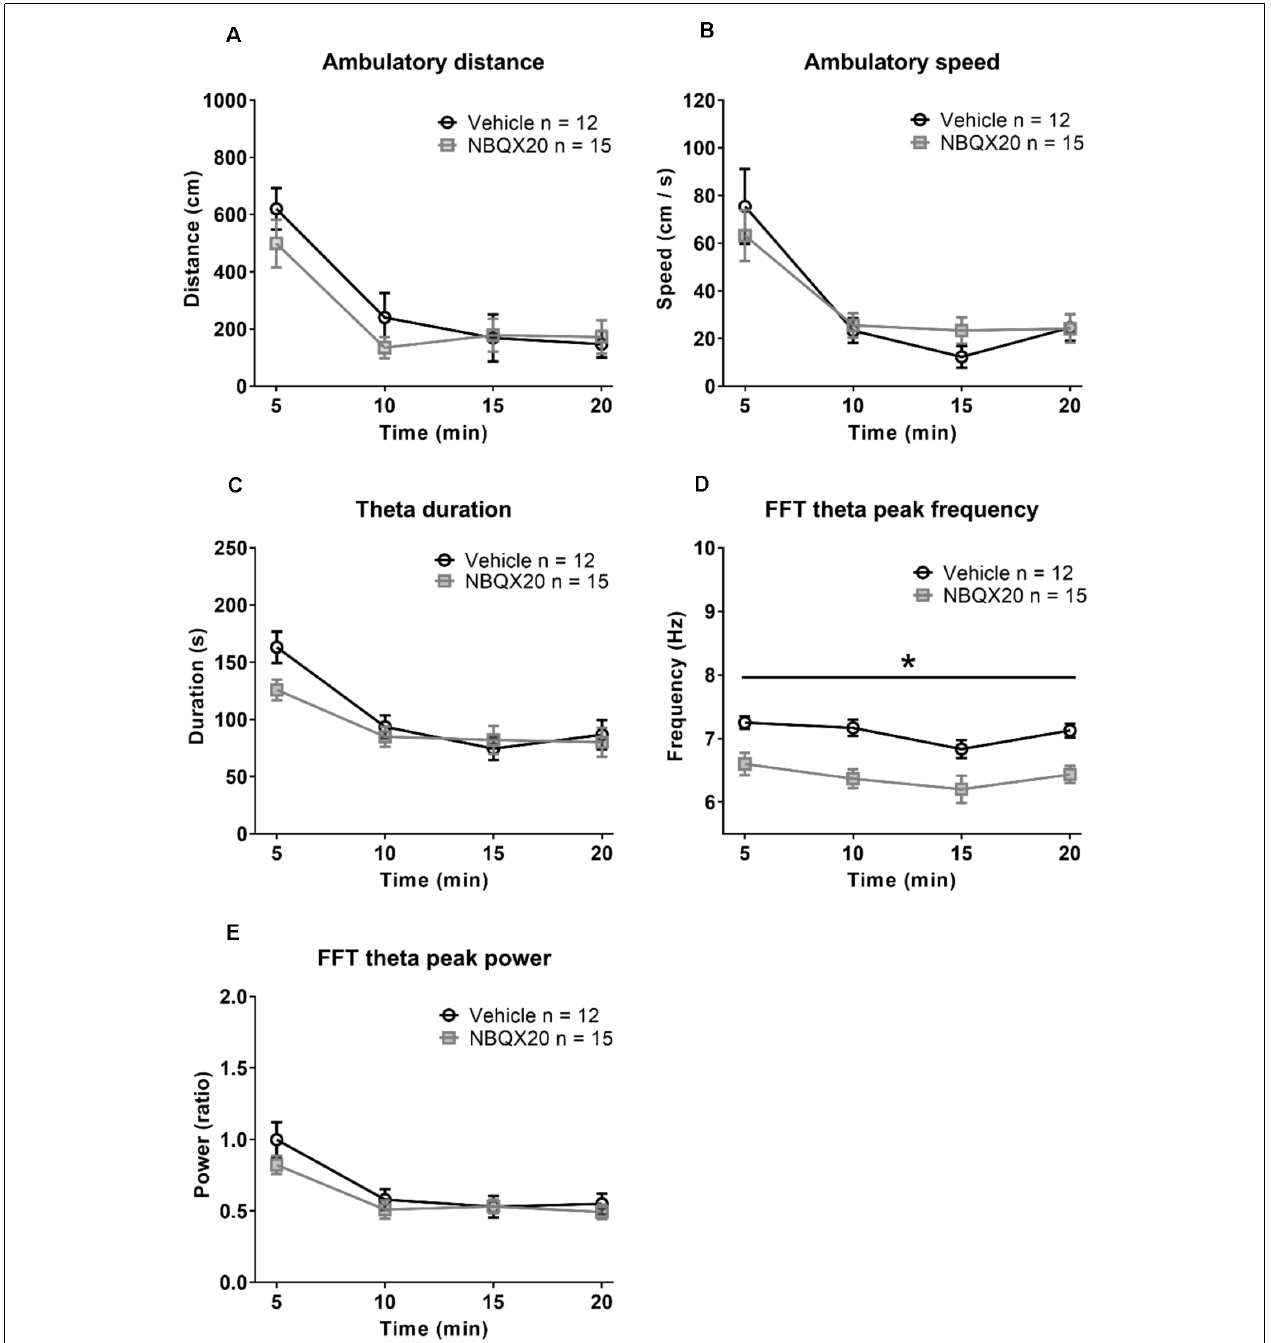
FIGURE 5 | Intraseptal microinjection of NBQX 20 µ g/ µ l attenuated theta wave frequency in novel open field (OF) with no effect on exploratory behavior. The figure illustrates the time courses of effects of intraseptal NBQX (20 µ g/ µ l, 0.5 µ l; ‘NBQX20’) on behavioral and electrophysiological parameters in a novel open field. The parameters measured included ambulatory distance (A) , ambulatory speed (B) , duration of theta wave activity (C) , FFT theta peak frequency (D) , and FFT theta peak power (E) . Vehicle or NBQX was microinjected either 5 or 15 min prior to the open field test. Since the effects of control microinjection of vehicle were very similar on the parameters, irrespective of time of microinjection, the data from the two control groups were combined. Likewise, for NBQX20. The theta duration was calculated as the sum of visible theta in 5 min block. The theta peak frequency (Hz) and theta peak power (peak-to-peak amplitude square in mV 2 unit) represent the values obtained from FFT analysis. The theta power was expressed as a ratio of the pre-treatment theta power recorded during exploration in a familiar environment before the experiment. NBQX20 induced a sustained decrease in FFT theta peak frequency (D) without any effect on the duration of theta activity (C) and FFT theta peak power (E) over the 20 min of observation. The ambulatory distance (A) and velocity (B) remained were not affected by the antagonist. Data are mean ± S.E.M. Significant difference ( p < 0.05): Time course: *NBQX20 vs. vehicle; two-way RM ANOVA followed by Bonferroni post hoc test.